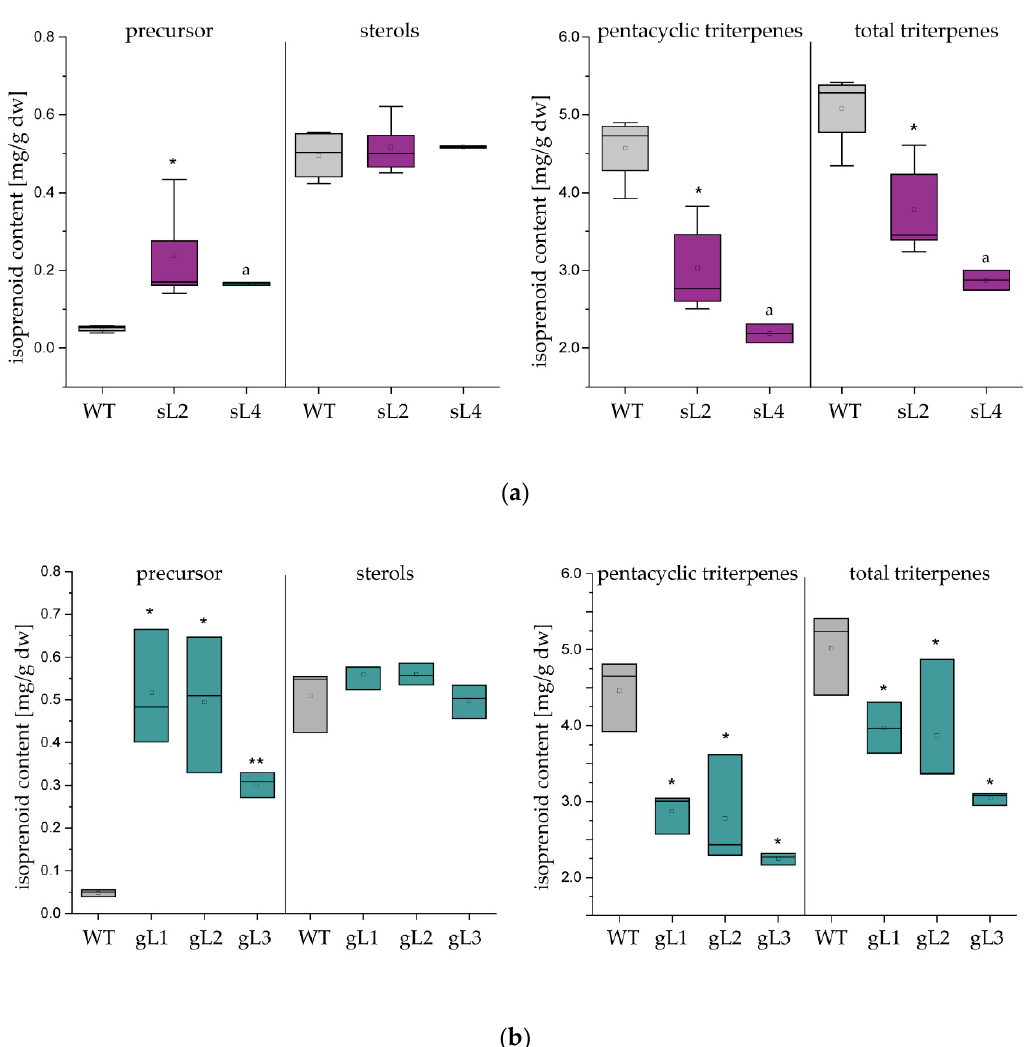
Figure 3. Isoprenoid analysis in freeze-dried root material from 6-month-old ( a ) TkOSC1 -RNAi and ( b ) TkOSC -RNAi plant lines by GC–MS compared to WT plants ( n = 2–5), a n = 2; asterisks denote statistical significance compared to control (two-tailed t test, * p < 0.05, ** p < 0.01); precursor: triterpene (squalene and 2,3-oxidosqualene) and sterol precursor (cycloartenol and 24-methylene cycloartanol); sterols: campesterol, stigmasterol and sitosterol; pentacyclic triterpenes: taraxasterol, α - and ß-amyrin, lup-19(21)-en-3-ol, lupeol, taraxerol and four unknown triterpenes; total triterpenes: precursor, sterols and pentacyclic triterpenes; single triterpene levels are shown in Tables S1 and S2.